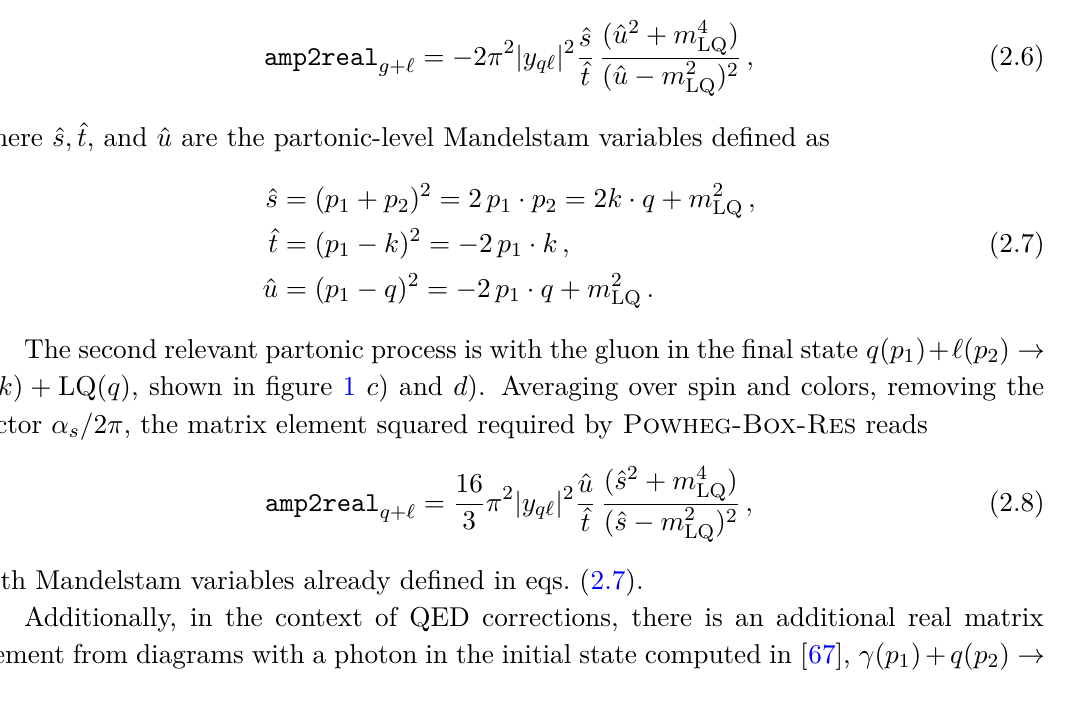
) . Diagrams c ) and d ) are for q ( p s ) s